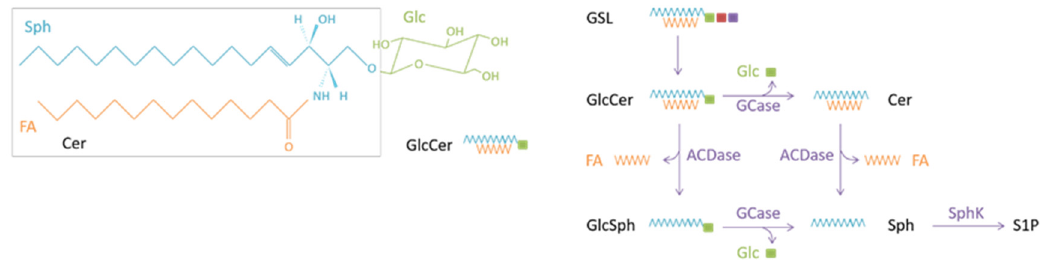
Figure 1. Glucosylceramide structure and metabolism. Abbreviations: Cer, ceramide; FA, fatty acid; Glc, glucose; GSL, glycosphingolipid; Sph, sphingosine; S1P, sphingosine 1-phosphate; SphK, sphingosine kinase. Fatty acids found in GlcCer usually include C16:0, C18:0, C22:0 and C24:1.